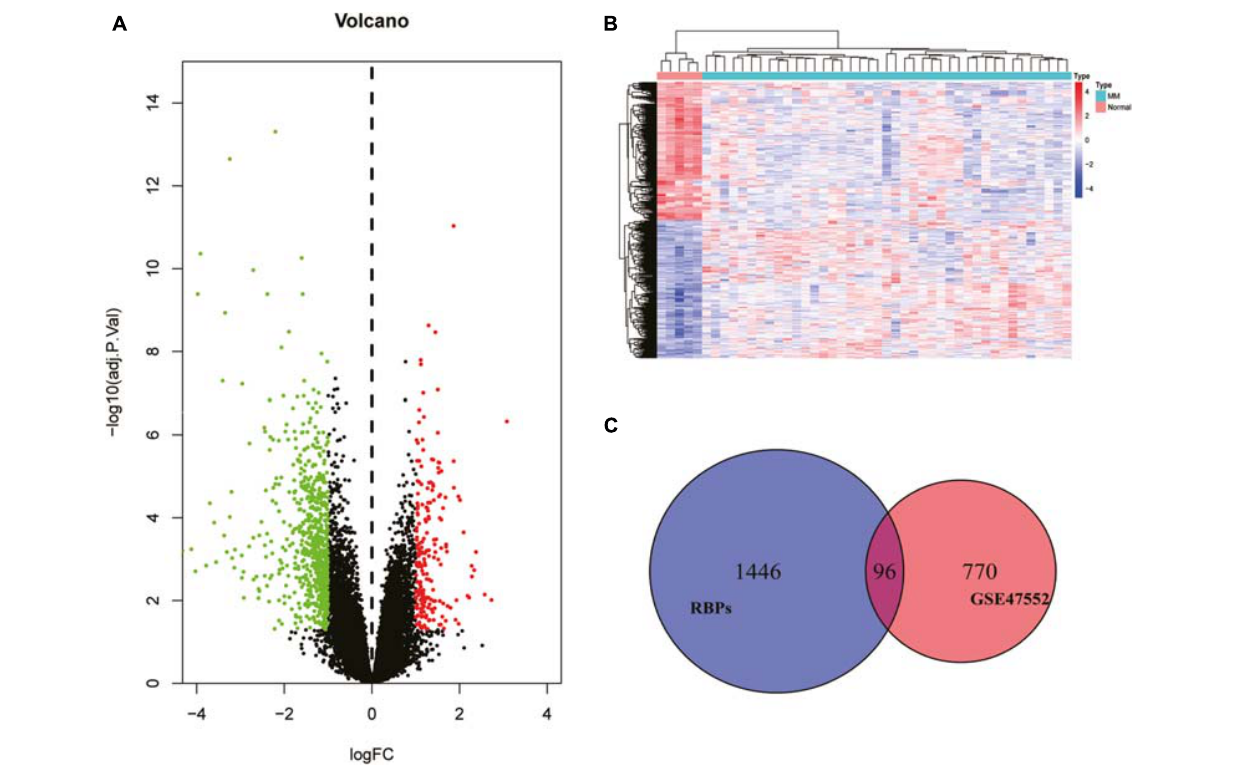
FIGURE 1 | Identification of differentially expressed genes. (A) Volcano plot of DEGs; (B) heat map of the top 200 DEGs; and (C) differentially expressed